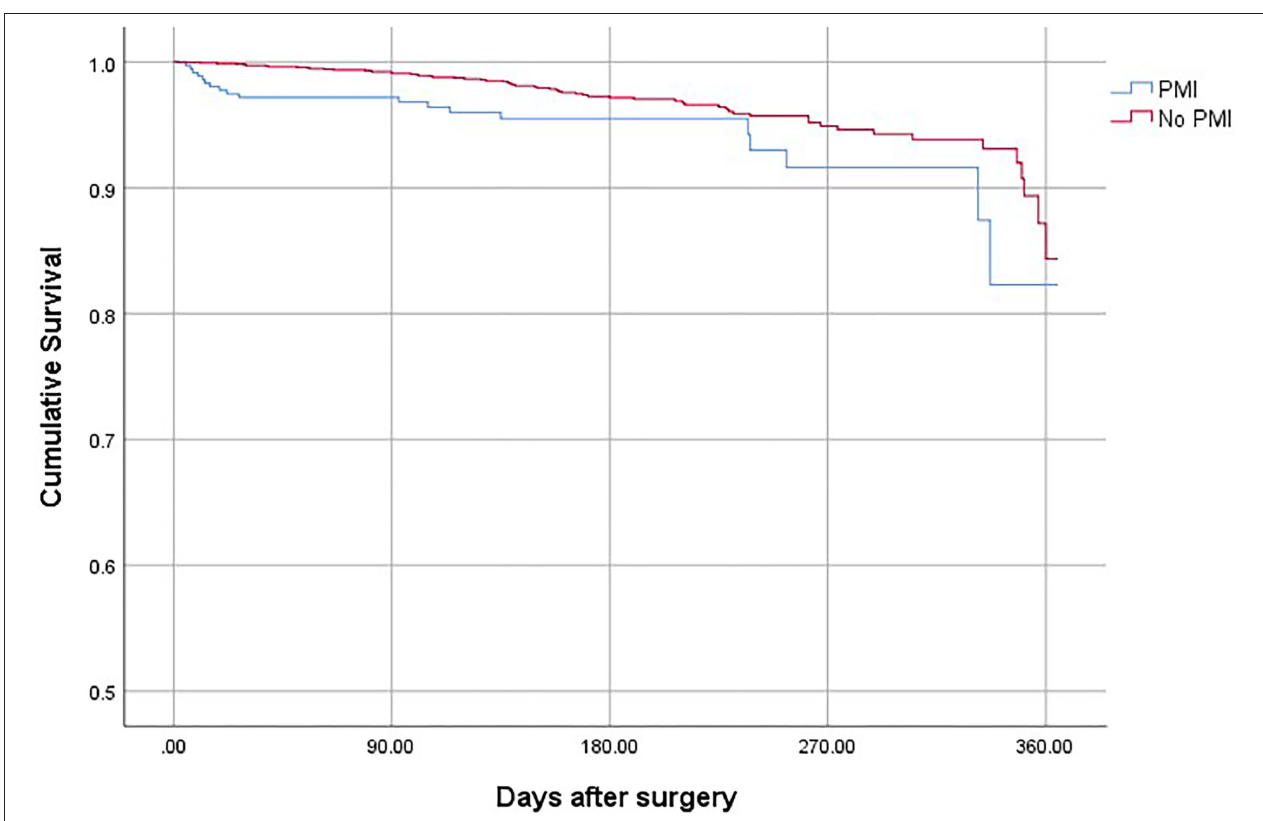
FIGURE 3 | The 1-year mortality for surgical patients with and without